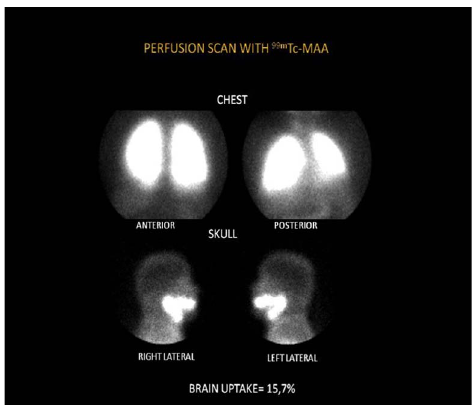
Figure 1. Anormal scintigraphy. Brain